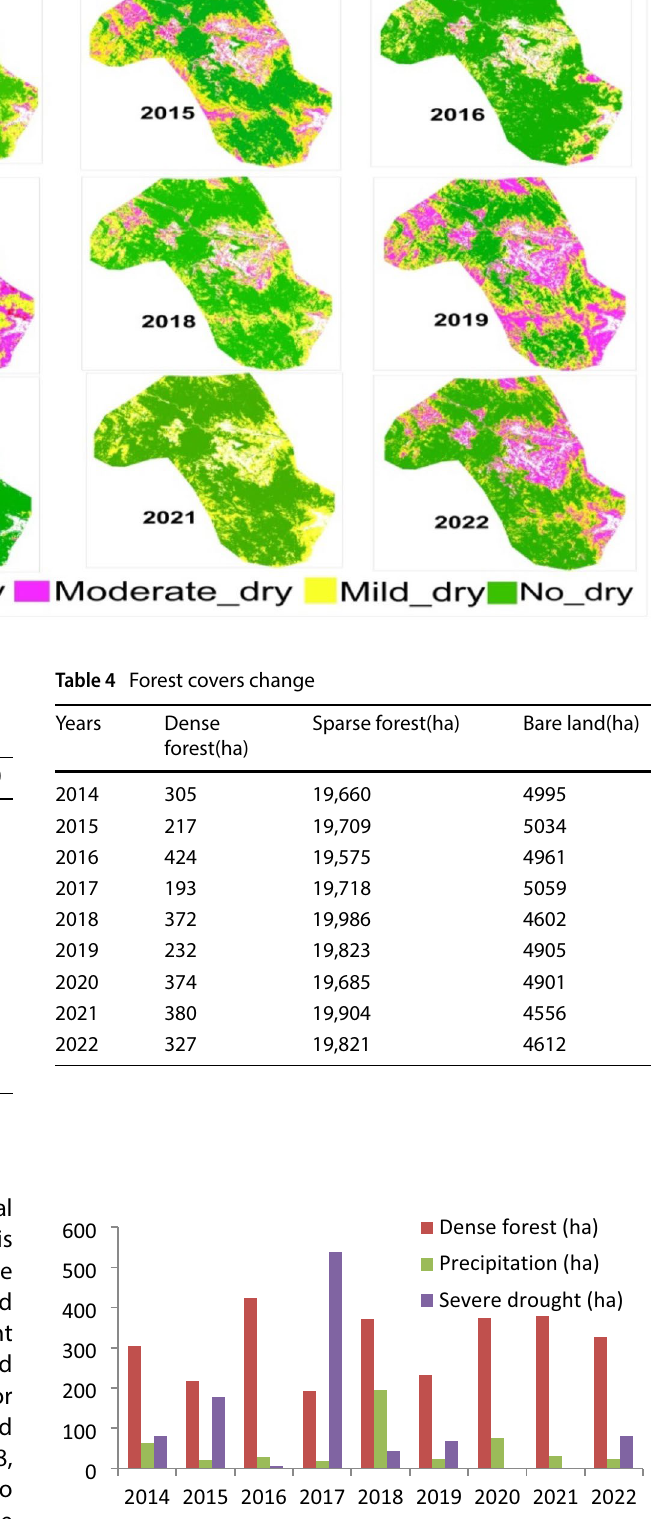
Fig. 3 Spatial map of drought severity class